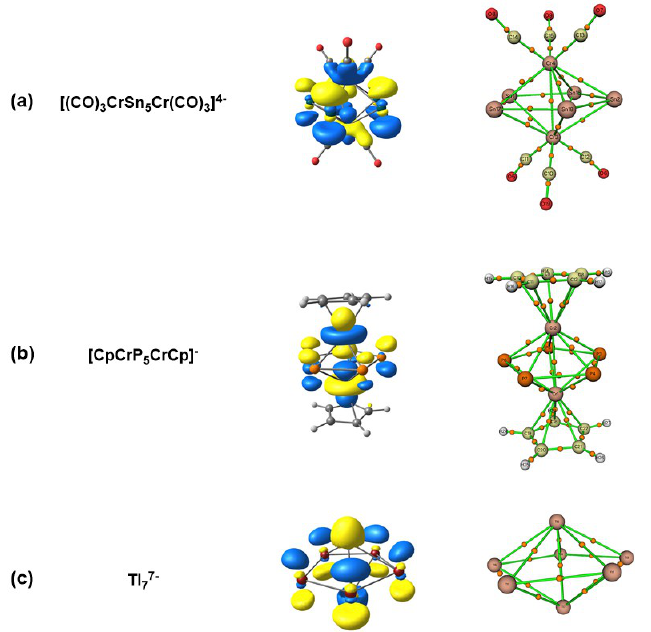
Figure 5. Contour plots of the LUMOs of ( a ) [(CO) ( c ) Tl 7 − and the corresponding molecular graphs. Bond Critical Points (BCPs) are shown in the 7 molecular graphs as orange